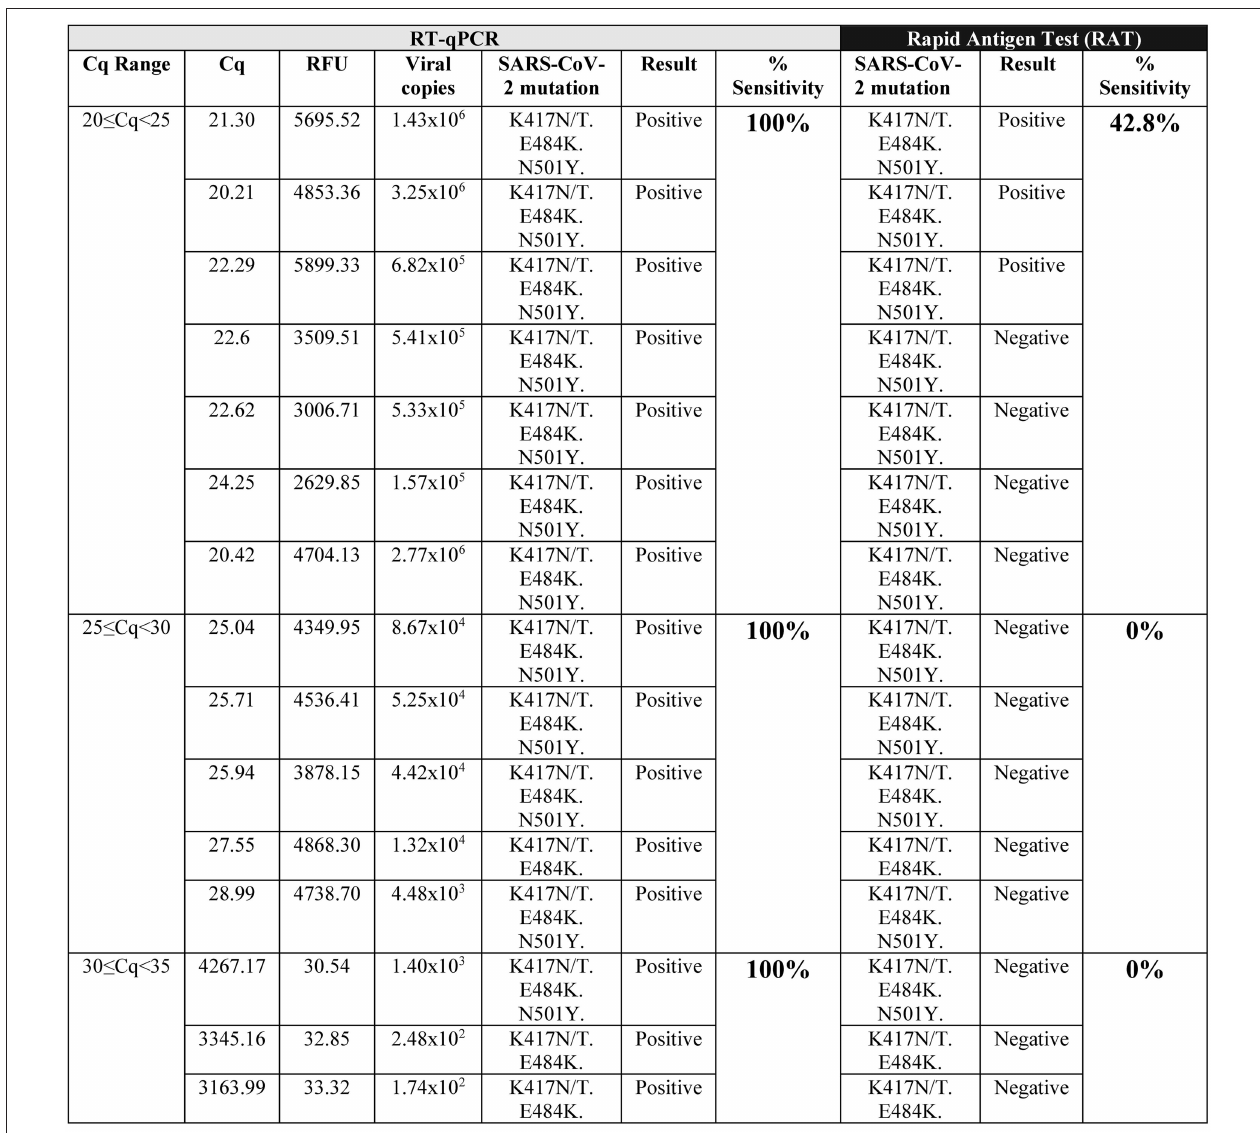
FIGURE 2 | SARS-CoV-2 Variant detection by RAT. RAT detection of SARS-CoV-2 variants which contain K417N/T, E484K, and N501Y mutations, from RT-qPCR positive samples with Cq value between 20 ≥ Cq < 25, 25 ≥ Cq < 30, 30 ≥ Cq < 35. All samples were positive by RT-qPCR. Table shows: the RFU (relative fluorescence units) and Cq value for the viral ORF1ab probe ( n = 16).